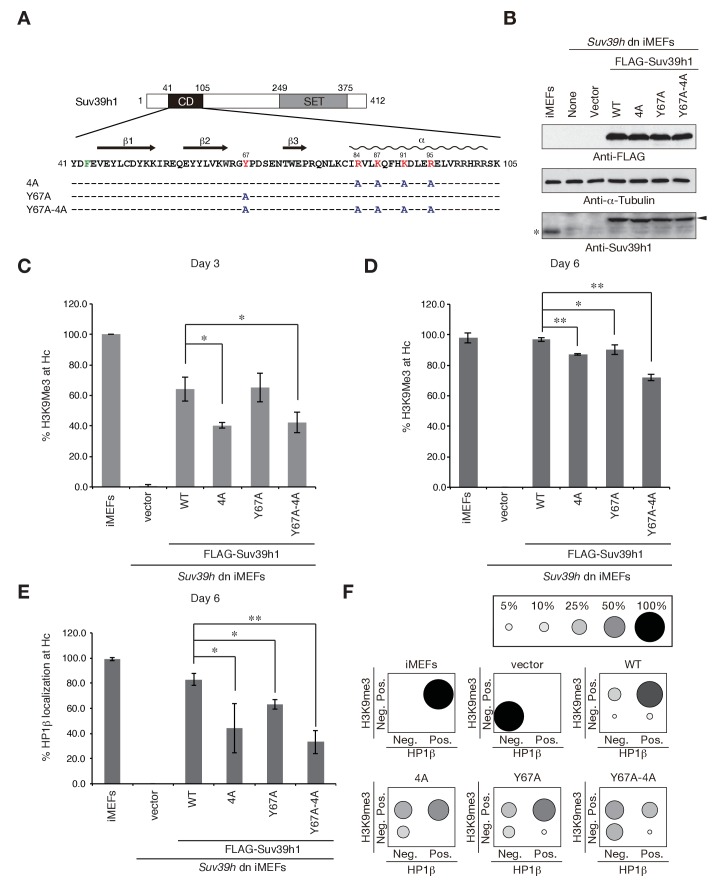
Suv39h1-CD’s nucleic acid binding and H3K9me binding are both crucial for pericentric heterochromatin assembly.(A) Alignment of wild-type (WT) and mutant full-length Suv39h1. Boxes outline the chromodomain (shaded black), and the SET domain (shaded gray). (B) Suv39h1 protein expression level. *Endogenous Suv39h1; arrowhead: FLAG-Suv39h1. (C–D) Kinetic comparison of the appearance ratio of the cells containing H3K9me3+ DAPI-dense foci after induction of WT and mutant Suv39h1 in Suv39h dn iMEFs. Immunohistochemical staining for H3K9me3 in WT iMEFs, Suv39h dn iMEFs, or Suv39h dn iMEFs expressing FLAG-tagged 4A, Y67A, Y67A-4A, or WT Suv39h1 at (C) 3 days or (D) 6 days post-infection. The H3K9me3-positive cells within a population of 100 or more cells were counted (n = 3, mean ± SD, *p<0.05, **p<0.001). (E) The rate of HP1β heterochromatin accumulation in WT and mutant Suv39h1 during heterochromatin establishment. Immunohistochemical staining for HP1β in WT iMEFs, Suv39h dn iMEFs, or Suv39h dn iMEFs expressing FLAG-tagged 4A, Y67A, Y67A-4A, or WT Suv39h1 at 6 days post-infection. (F) HP1β accumulated at heterochromatin in cells where H3K9me3 was restored. The radii of the circles indicate the number of cells in each category. Immunohistochemical staining for HP1β in WT iMEFs, Suv39h dn iMEFs, or Suv39h dn iMEFs expressing FLAG-tagged 4A, Y67A, Y67A-4A, or WT Suv39h1 at 6 days post-infection. The cells with HP1β heterochromatin accumulation within a population of 100 cells or more were counted (n = 3, mean ± SD, *p<0.05, **p<0.005). The radii of the circles indicate the % ratio of cells in each category.